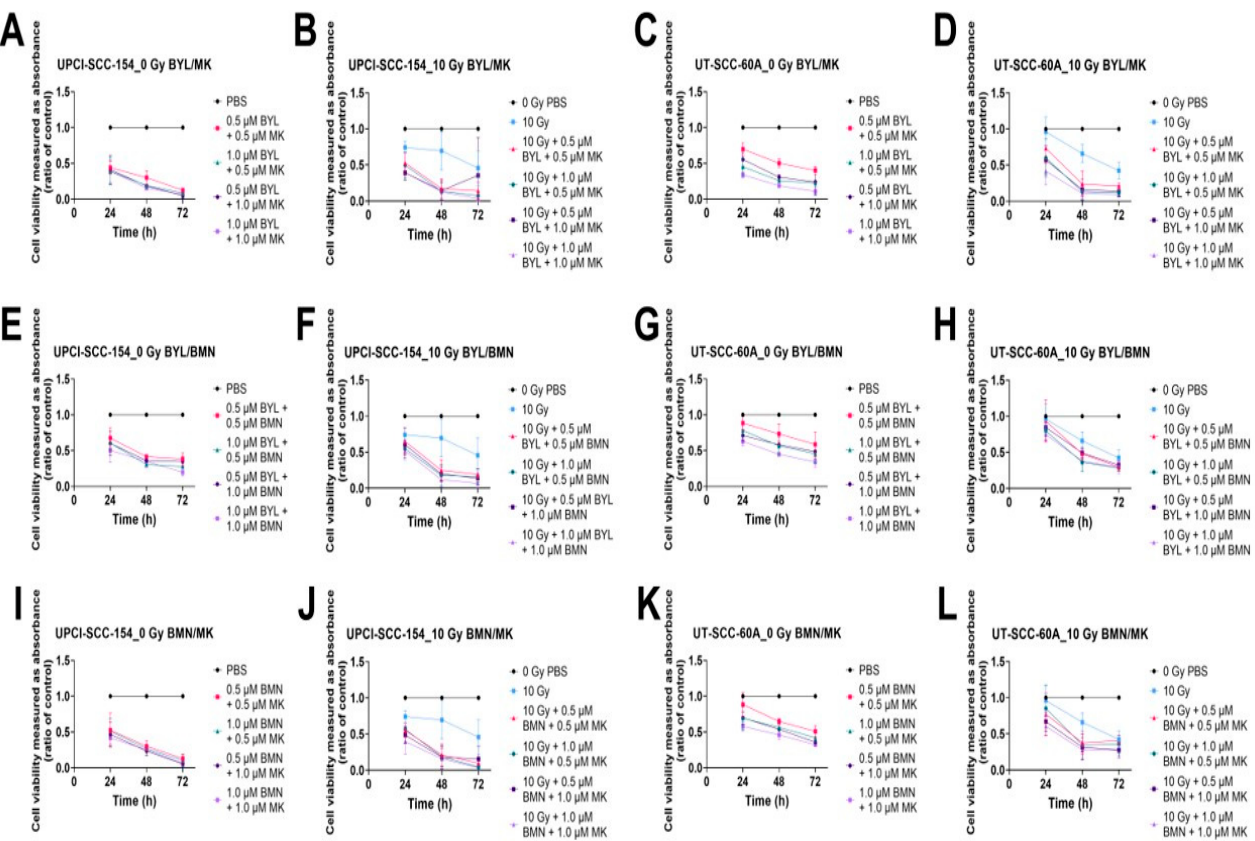
Figure 3. WST-1 assay on the HPV + UPCI-SCC-154 and HPV − UT-SCC-60A lines. Cell viability measured as absorbance after 24, 48, and 72 h of combined treatments with BYL719/MK-1775 ( A – D ), BYL719/BMN-673 ( E – H ), and BMN-673/MK-1775 ( I – L ) with/without 10 Gy. BYL denotes BYL719, BMN denotes BMN-673, and MK denotes MK-1775.